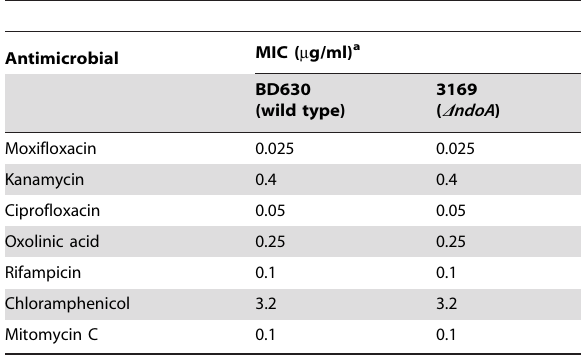
Table 1. Antimicrobial susceptibility (Minimal Inhibitory Concentration (MIC)) with B. subtilis